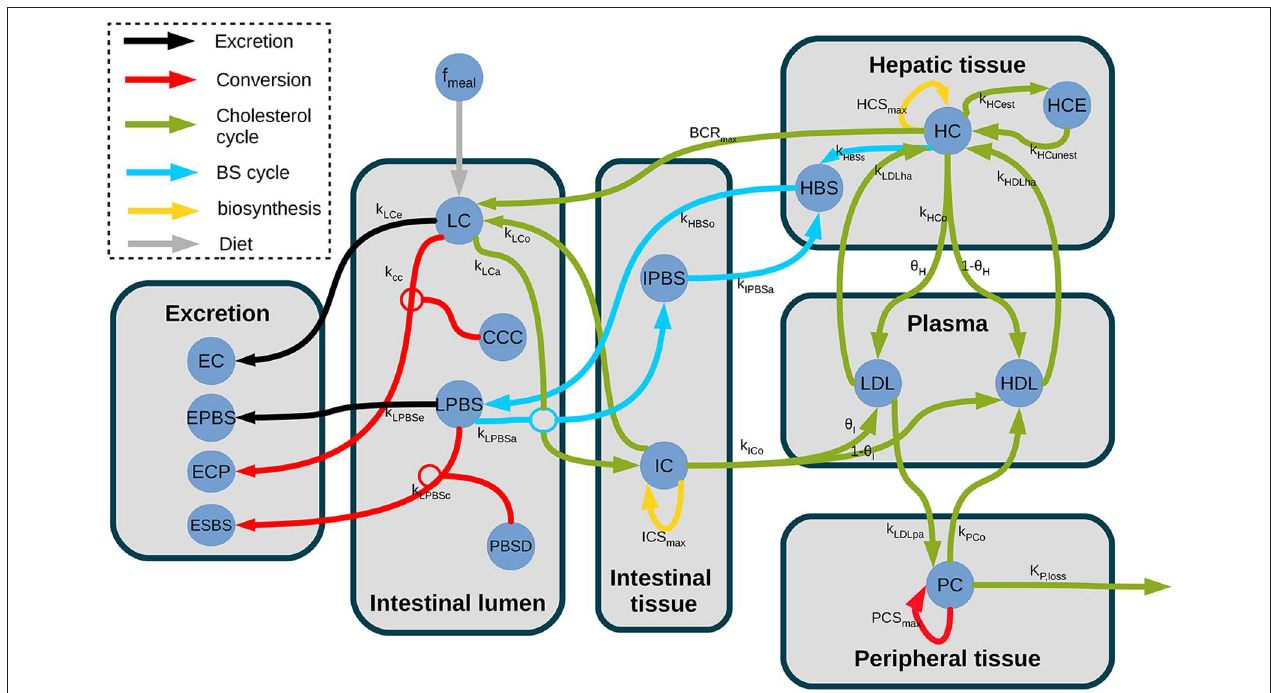
FIGURE 3 | Structure of the model of whole-body cholesterol metabolism. The different compartments included in the model are displayed as gray boxes. The cholesterol flux are indicated by arrows. The gray arrows display the dietary cholesterol influx while the black arrows show the excretion and the orange arrows represent the bacterial transformations. The entero-hepatic BS cycle is displayed in light blue, while the cholesterol cycle is represented in green. The yellow arrows represent the cholesterol biosynthesis. f meal , dietary cholesterol; LC, luminal cholesterol; CCC, coprostanol-to-cholesterol converter; LPBS, luminal primary bile salts; PBSD, primary bile salts converter; EC, excreted cholesterol; EPBS, excreted bile salts; ECP, excreted coprostanol; ESBS, excreted secondary bile salts; IPBS, intestinal primary bile salts; IC, intestinal cholesterol; LDL, low density lipoprotein; HDL, high-density lipoprotein; HC, hepatic cholesterol; HCE, hepatic cholesterol esters; HBS, hepatic bile salts; PC, peripheral cholesterol; k LCe , Luminal cholesterol excretion; k cc , Cholesterol conversion to coprostanol; k LPBSe , Luminal PBS excretion; k LPBSc , Luminal PBS conversion to SBS; k LCa , Luminal cholesterol absorption; k LPBSa , Luminal PBS absorption; k LCo , Epithelial cholesterol secretion in lumen; ICS MAX , Intestinal synthesis maximal rate; k ICo , Intestinal cholesterol outflow; θ I , Proportion of cholesterol in LDL; k IPBSa , PBS absorption by the liver; k HBSo , BS outflow in lumen; k LDLpa , peripheral absorption in LDL pool; PCS MAX , Peripheral synthesis maximal rate; k PCo , Peripheral cholesterol outflow; k P , loss , Cholesterol storage; k HCo , Epithelial cholesterol outflow; θ H , proportion of cholesterol in LDL; k HBSs , BS synthesis from cholesterol; BCR MAX , Chol. release maximal rate; HCS MAX , Hepatic synthesis max. rate; k HCest , Esterification; k HCunest , Unesterification; k LDLha , Hepatic absorption in LDL pool; k HDLha , Hepatic absorption in HDL